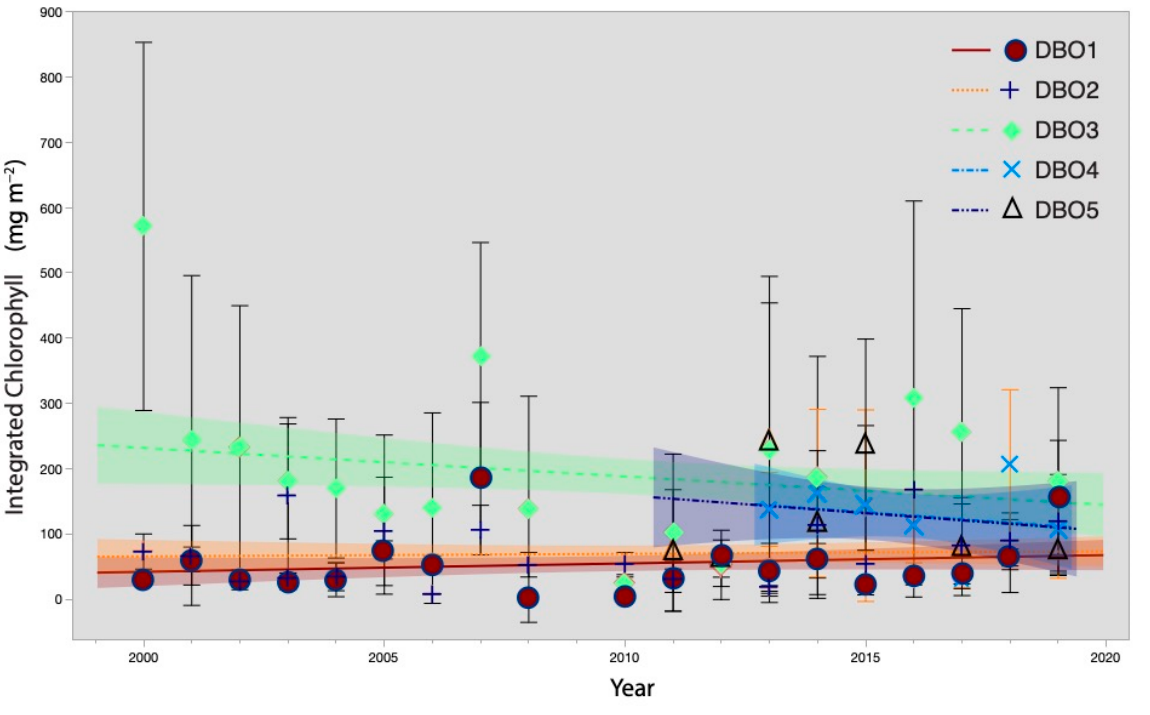
Figure 2. Variation in chlorophyll-a among all DBO stations sampled, integrated over the whole water column. Error bars shown are standard deviations from the mean in each year for each DBO region with shading representing the best linear fit for each re- gression line.